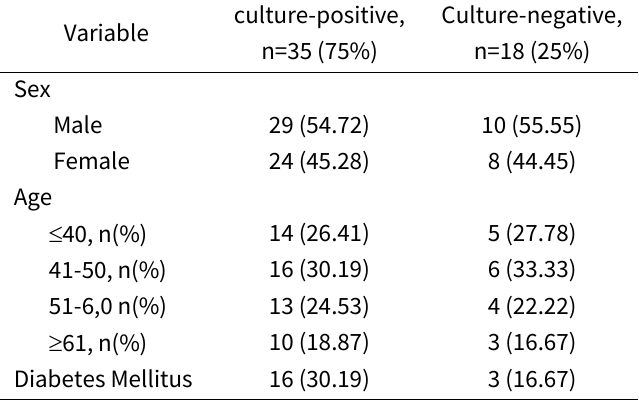
Table 2. Demographic Data of Peritonitis CAPD